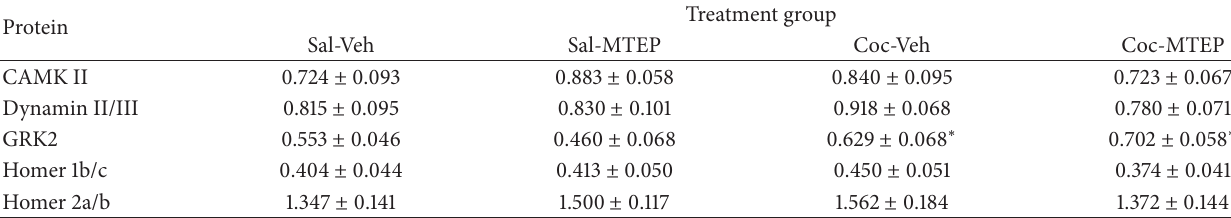
Table 1: Immunoreactivity of mGlu5-interacting proteins in the dlSTR 22 hr after the context-induced relapse test. Protein